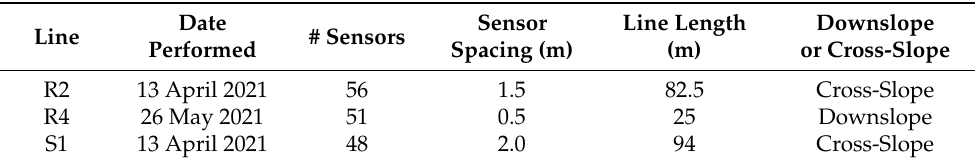
Table 1. Summary of geophysical survey parameters for both electrical resistivity (R2 and R4) and seismic (S1)